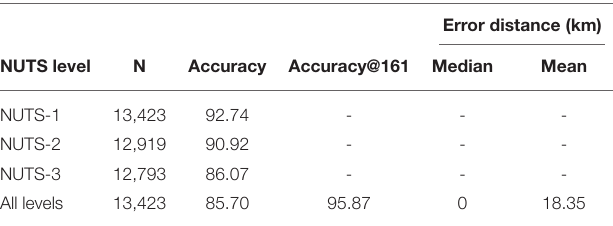
TABLE 4 | Performance of our geocoding